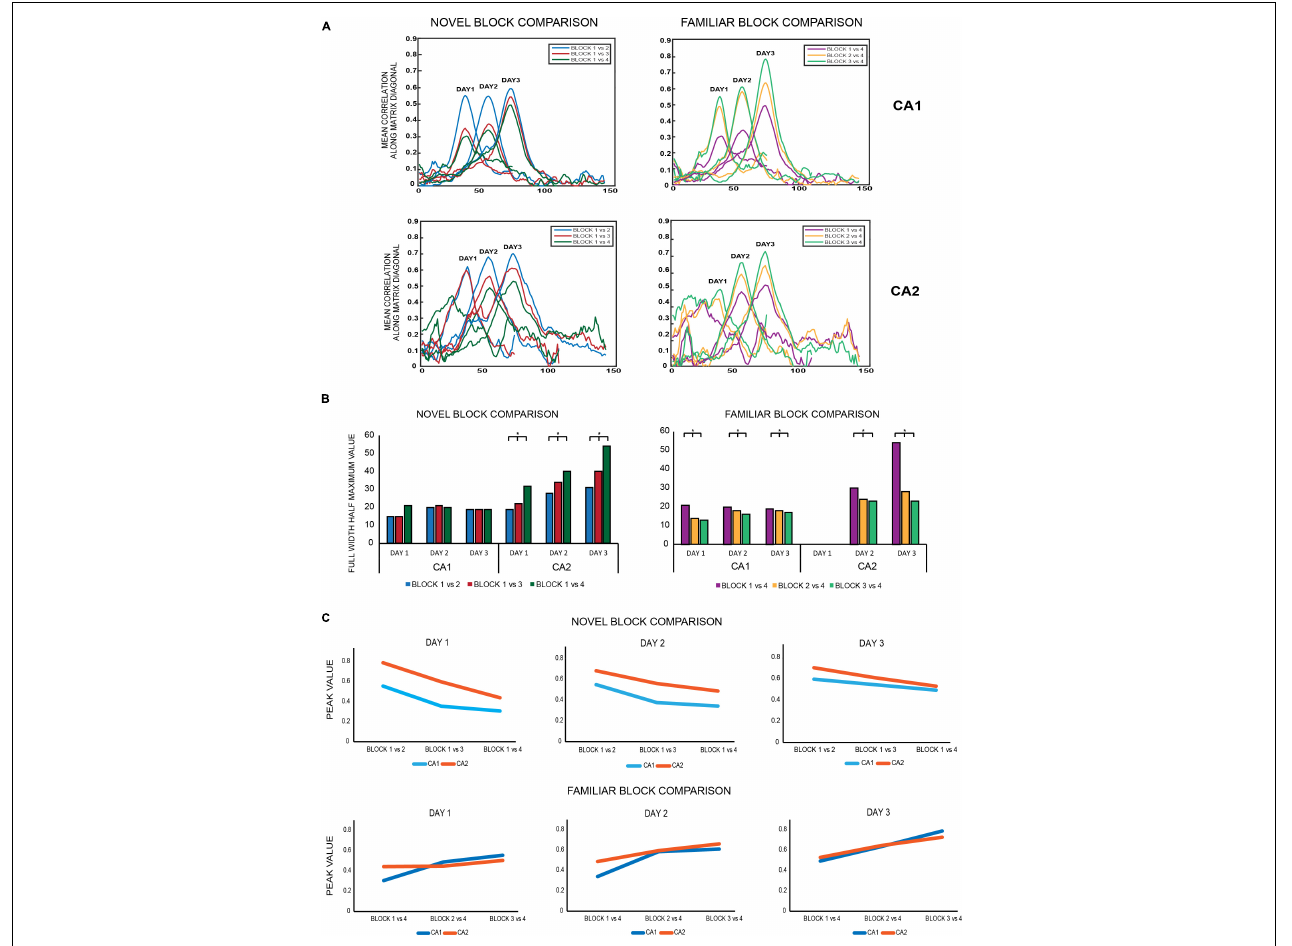
FIGURE 5 | (A) Novel block comparison: All 2D correlation plots were converted to 1D correlation curves by averaging the correlation values of the 2D matrix along the diagonal and subsequently were termed as 1D diagonal correlation plots. All diagonal correlation plots were smoother for CA1 than for CA2. Within each day, correlation values at the diagonal were highest for the block 1 vs. 2 matrix (blue) followed by block 1 vs. 3 (red) and least for block 1 vs. 4 (dark green) for both ensembles, indicating that population correlations were highest for successive block comparisons and decreased for non-successive block comparisons as time between the blocks being compared increased. Familiar block comparisons: the same comparisons revealed the same trend as observed for novel block comparisons, with the highest correlation observed for successive block comparisons (block 3 vs. 4, indicated in light green), followed by non-successive block comparisons of block 2 vs. 4 (yellow) and least for block 1 vs. 4 (magenta) for both CA1 and CA2 ensembles. All diagonal correlation plots were again smoother for CA1 than for CA2. (B) Novel block comparison – The strength of spatial correlations was measured by FWHM (full-width half-maximum) values, since polar plots could not be constructed for non-circular tracks. Within each day, FWHM values for all novel block comparisons increased from successive to non-successive block comparisons for CA2 but remained similar and comparable for CA1 (Jonckheere-Terpstrsa test: CA1: p = 0.158, CA2: p = 0.022). Moreover, for each of the individual novel block comparisons, their respective FWHM values increased across days for CA2 but not for CA1 (Jonckheere-Terpstrsa test: day 1 vs. day 2 vs. day 3: FWHM novel block comparison: CA2: p = 0.0227, CA1: p = 0.412). Finally, the FWHM values were compared for each novel block comparison between CA1 and CA2 for all days, and the values were only comparable on day 1 but not on subsequent days, with CA2 having higher values (Jonckheere-Terpstrsa test: CA1 vs. CA2 FWHM values: day 1: p = 0.0633, day 2: p = 0.024, and day 3: p = 0.0247). Familiar block comparison – For this comparison, both CA1 and CA2 followed the same trend in the strength of their spatial correlations: highest for successive block comparisons and steady decrease for non-successive comparisons (except for day 1 for CA2 due to less number of neurons firing in the last block for day 1) (Jonckheere-Terpstrsa test: FWHM familiar block comparison: CA1 ensemble: p = 0.0053, CA2 ensemble: p = 0.0085). Moreover, for both CA1 and CA2 ensembles, each familiar block comparison values did not vary across days and instead remained comparable (Jonckheere-Terpstrsa test: all familiar block comparisons: day 1 vs. day 2 vs. day 3: CA1: p = 0.252, CA2: p = 0.275). FWHM value comparisons between CA1 and CA2 again revealed significant differences between the two for both days 2 and 3 (comparison could not be made for day 1 because of low number of CA2 cells in block 4 for that day) (Jonckheere-Terpstrsa test: CA1 vs. CA2 FWHM values: day 2: p = 0.0247 and day 3: p = 0.02). (C) Peak correlation values were also compared for novel and familiar block comparisons for CA1 and CA2 populations. For novel block comparisons (top), within-day responses remained the same for both ensembles on all days, with highest peak observed for successive block comparisons (block 1 vs. 2) and least for non-successive blocks (block 1 vs. 4). However, peak correlations were significantly higher for CA2 than for CA1 in all comparisons and on all days (Jonckheere-Terpstrsa test: CA1 vs. CA2 peak correlation value: day 1 vs. day 2 vs. day 3: p = 0.0053), although as overall familiarity increased across days, the difference between peak correlation values for the two ensembles decreased. For familiar block comparisons, on the other hand (bottom), peak values were similar and comparable for CA1 and CA2 ensembles for both within day and across days (Jonckheere-Terpstrsa test: CA1 vs. CA2 peak correlation value for day 1 vs. day 2 vs. day 3: p = 0.369) (* indicates p < 0.05). Thus, while there were differences in CA1 and CA2 population responses to novel block comparisons, both ensembles did not vary in their responses to familiar block comparisons in any way, highlighting CA2’s different responses to spatial